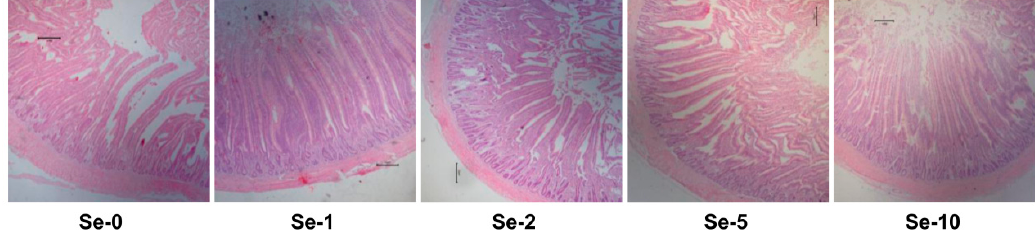
Figure 1. Effects of dietary selenium sources on the morphology of the jejunum in laying hens. The pictures (40×) are representative of the jejunum section with hematoxylin and erosion (HE) staining. Se-0: the birds fed the basal diet; Se-1, Se-2, Se-5, and Se-10: the birds fed 1, 2, 5, and 10 mg/kg of selenium provided by selenium-enriched insect protein powder, respectively.